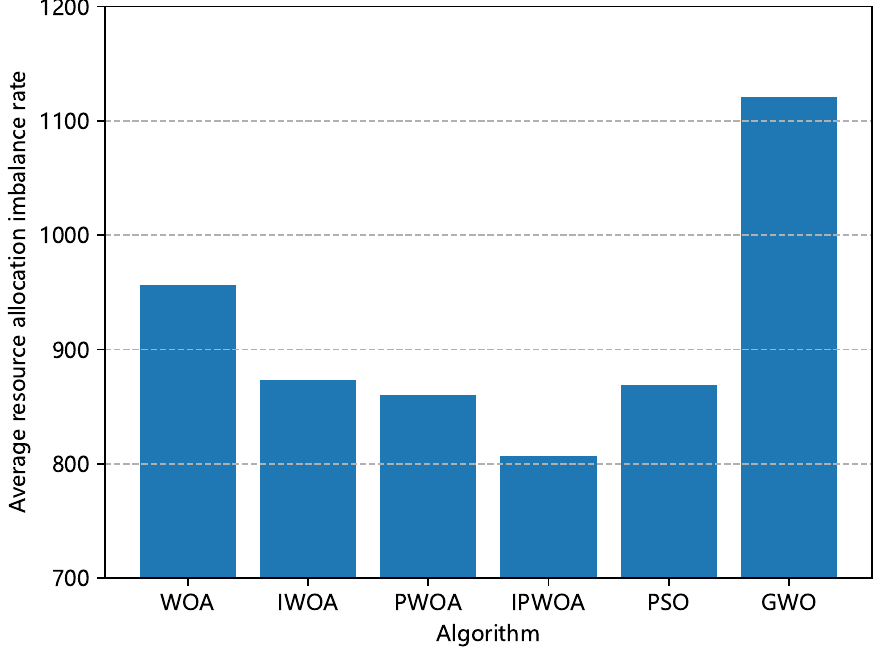
Figure 6. Comparison of the power consumption of resource devices generated by different algo- rithms. The resource device power consumption was generated by the optimal allocation scheme of each algorithm.